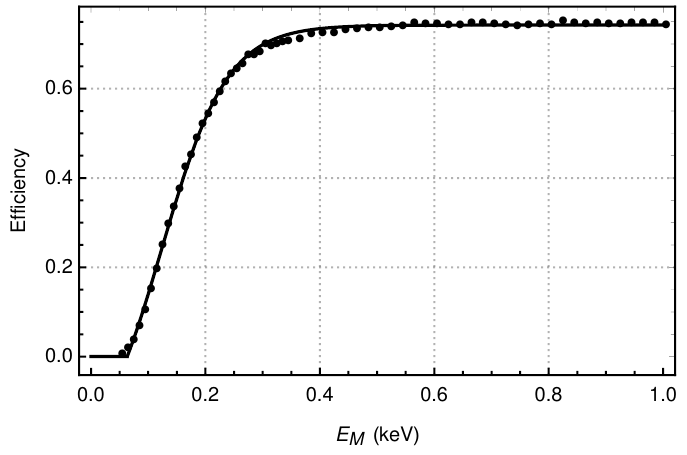
Figure 6 . Processing e(cid:14)ciency for CONNIE data obtained from simulated events [23] ( (cid:15) ) and the (cid:12)t described by eq. (B.3) (solid